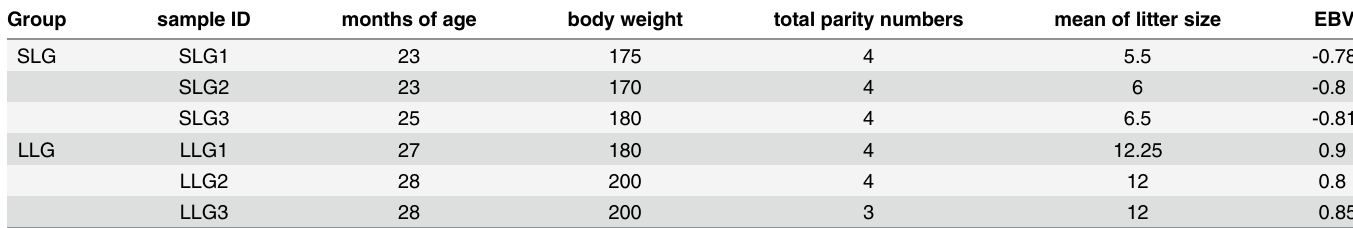
Table 1. Characteristics of the Berkshire pigs used in this study.